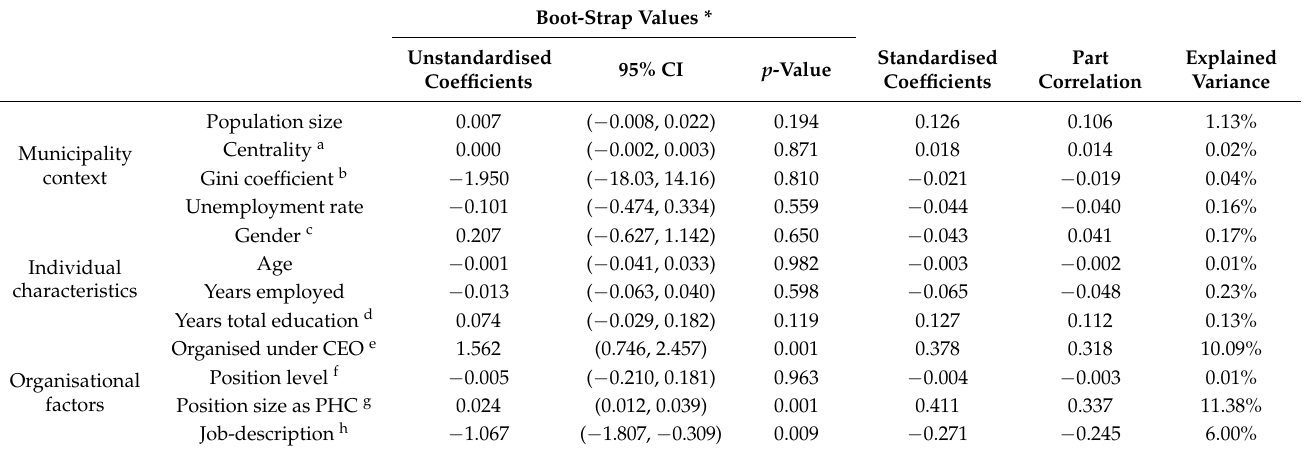
Table 4. Linear regression analysis ( n = 110) with 1000 bootstrap samples, testing single variables